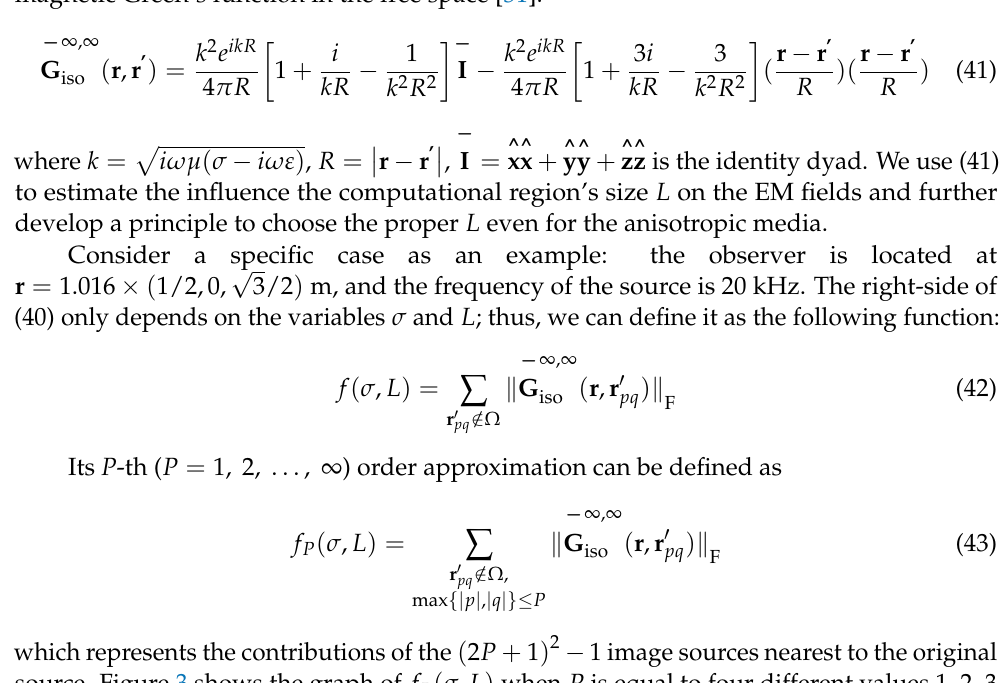
Figure 4. The graph of the function 3 ( , ) f L  and the illustration of the process for choosing proper region size.